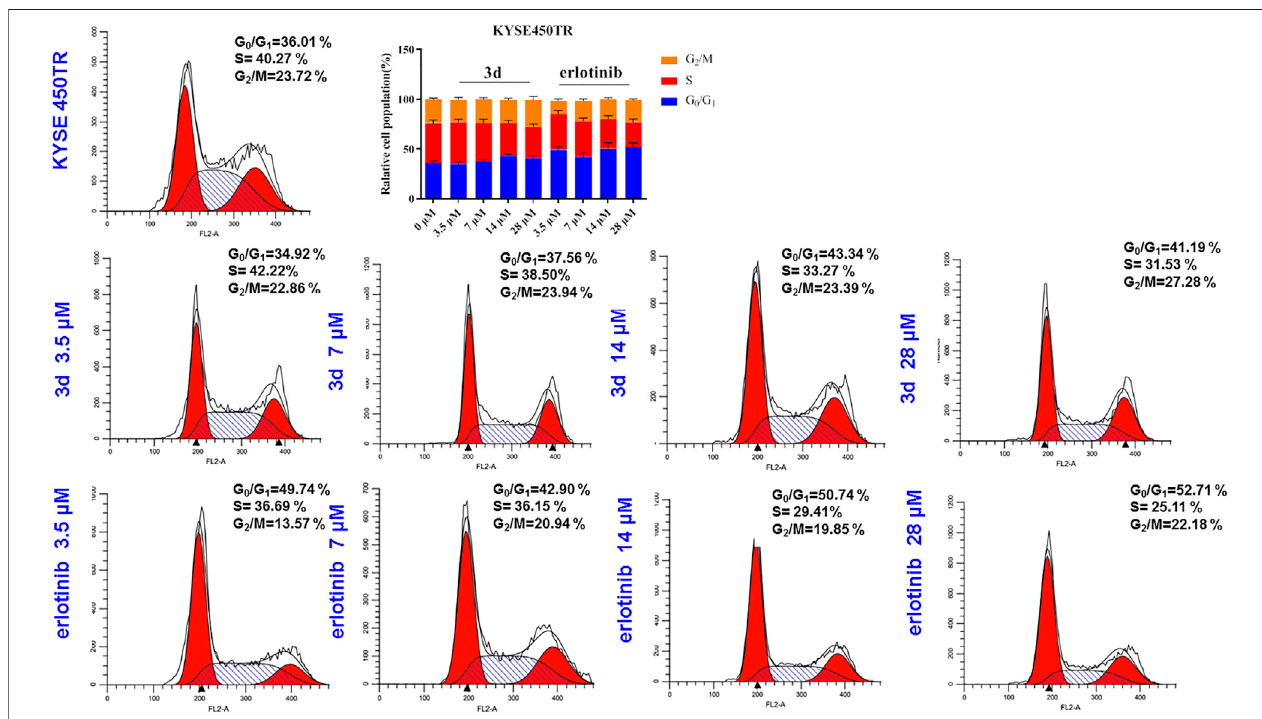
FIGURE 7 | Cell cycle arrests induced by compound 3d and erlotinib in KYSE450TR, compared with the cells treated with 0.1%